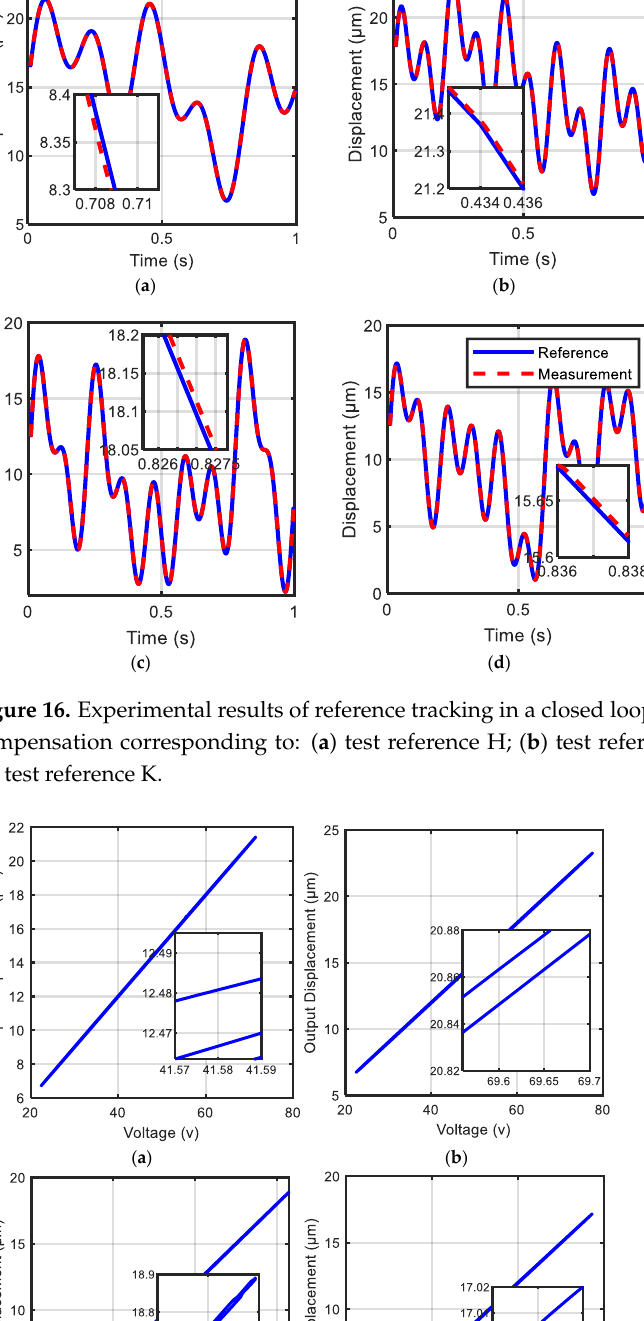
Figure 15. The effect of the proposed control scheme on hysteresis loops of the considered piezoe- lectric actuator. The loops shown were obtained by: ( a ) test reference D; ( b ) test reference E; ( c ) test reference F; and ( d ) test reference G.